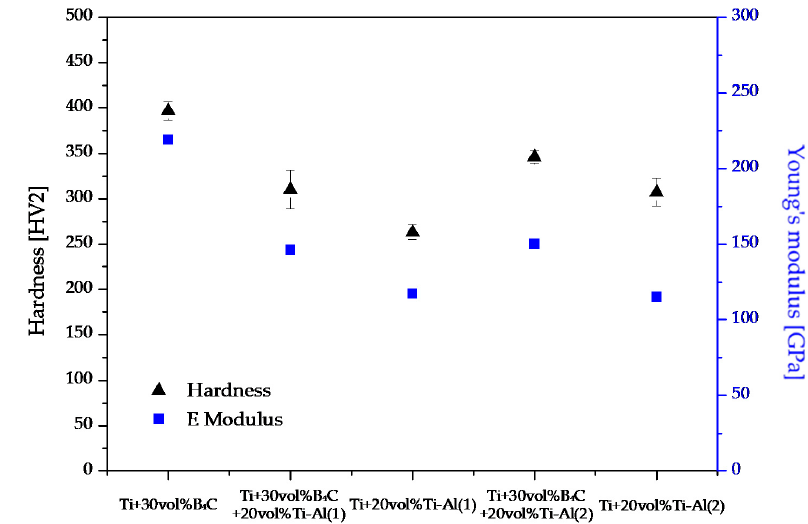
Figure 8. Hardness Vickers (HV2) and Young’s modulus of the specimens.